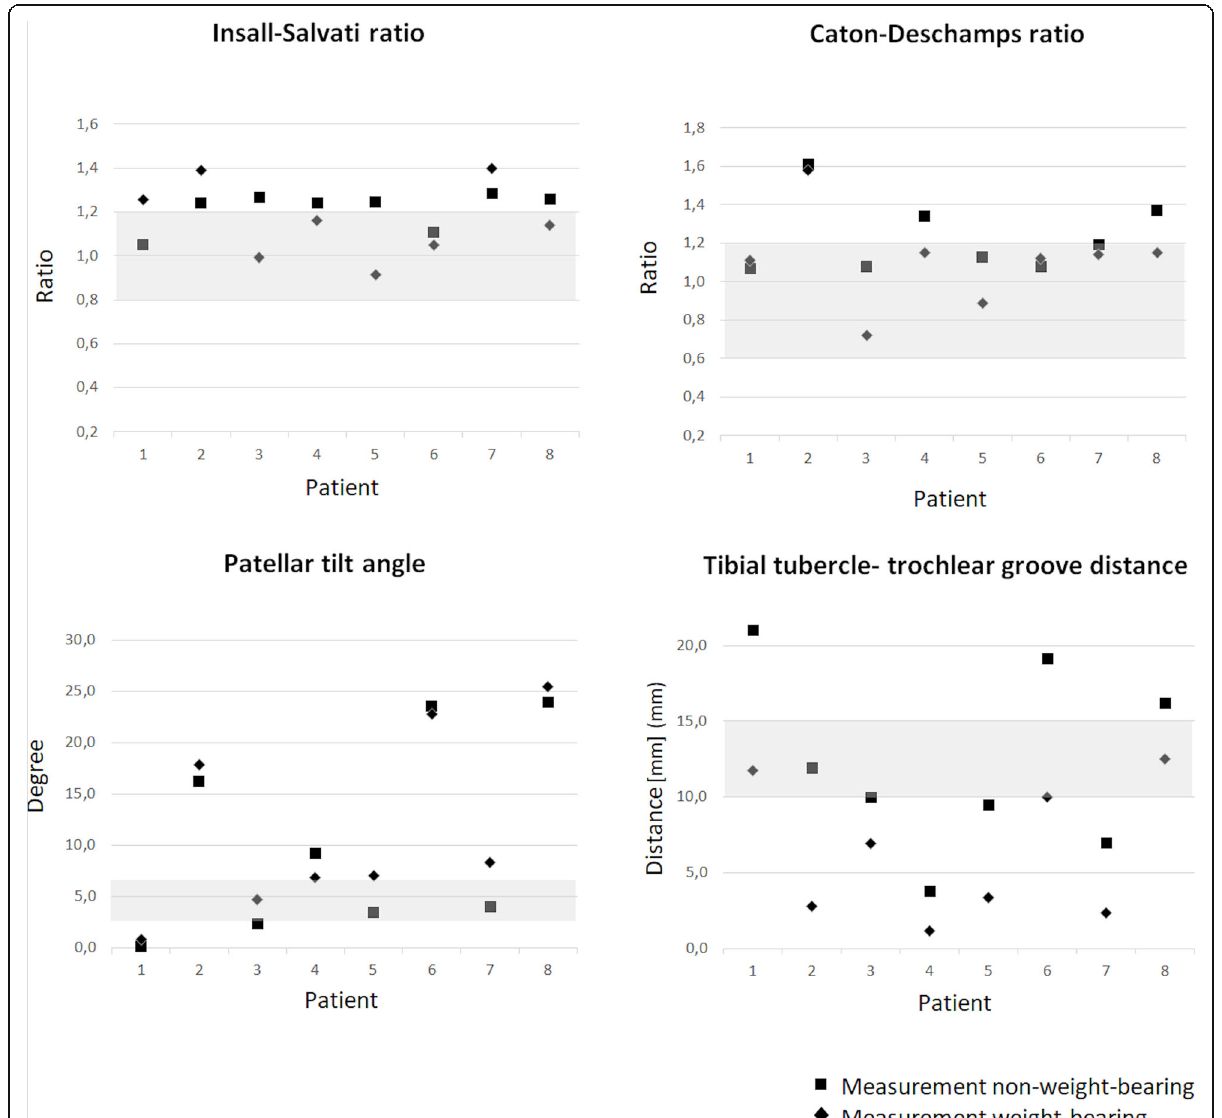
Fig. 7 Results of the patellofemoral measurements of eight patients with a problematic TKA, scanned in weight-bearing and non-weight-bearing conditions using low-field MRI to measure the IS and CD ratios, the PTA and the TT-TG distance. The grey areas are the ranges given in the literature for the native knee: Insall-Salvati ratio (0.8 – 1.2) [17], Caton-Deschamps ratio (0.6 – 1.2) [20], Patellar tilt angle (3 0 – 7 0 ) [17], tibial tubercle- trochlear groove distance (10 – 15 mm)